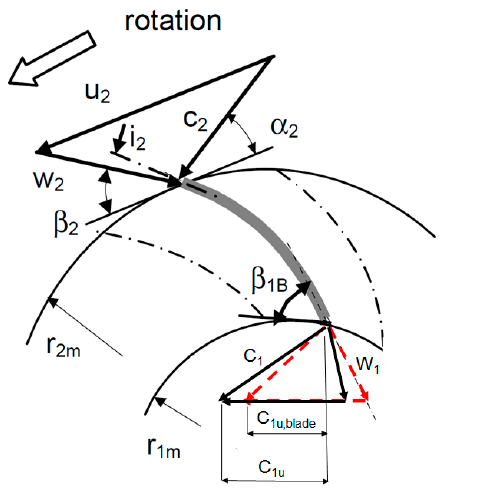
Figure 6. The slip phenomenon at the outlet section of the